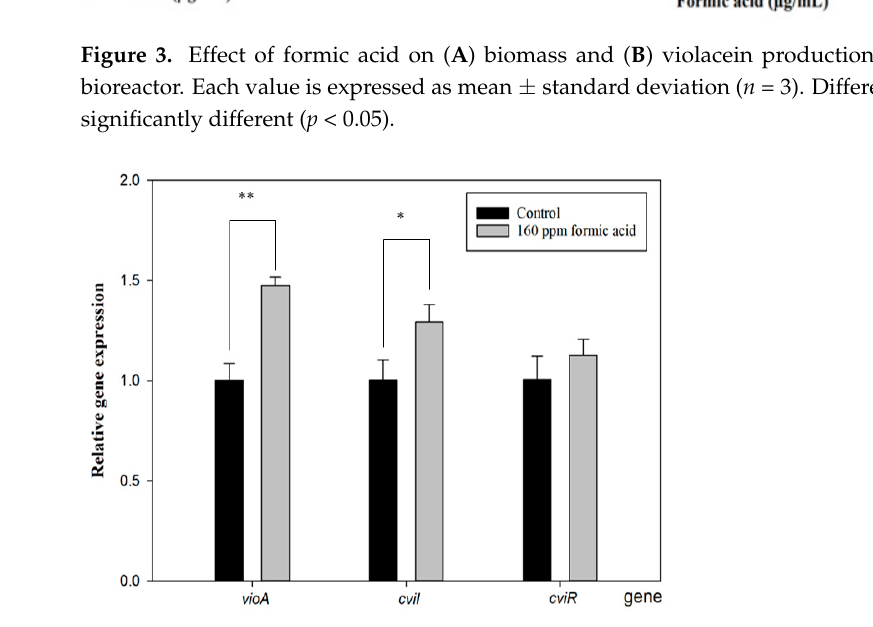
Figure 4. Effect of formic acid on the gene expression of vioA , cviI , and cviR in C. violaceum . Each value is expressed as mean ± standard deviation ( n = 3). Asterisk represents a significant difference (* p < 0.05, ** p < 0.01).